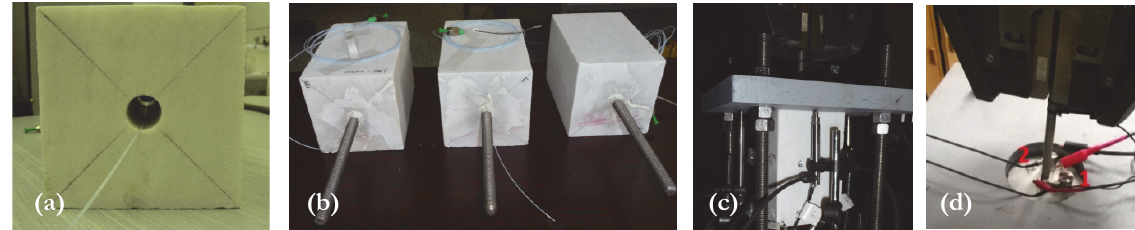
Figure 1: (a), (b) Typical pull out specimens; (c), (d) The experimental set up [2, 3].